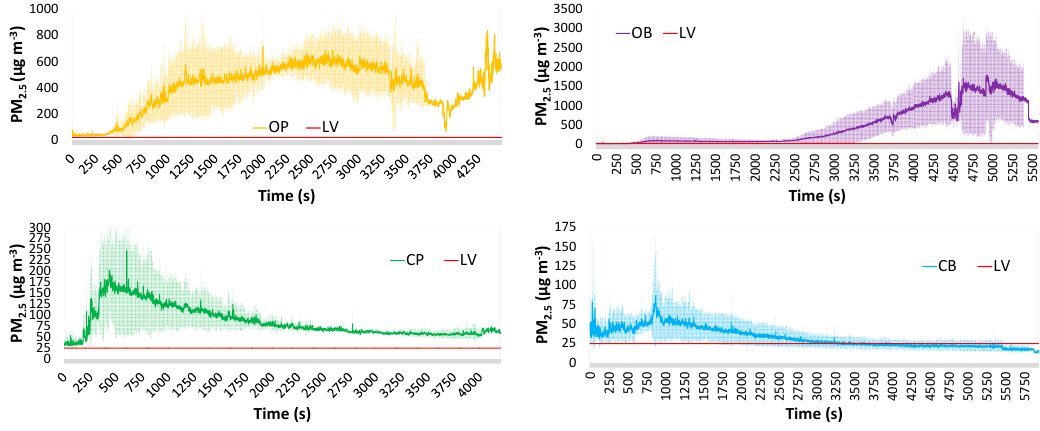
Figure 10. Temporal variability of PM 2.5 (line—mean; light coloured area—standard deviation) during the combustion period for the four studied conditions: ( top , left ) OP—open fireplace and pinewood, ( top , right ) OB—open fireplace and briquettes, ( bottom , left ) CP—closed fireplace and pinewood, and ( bottom , right ) CB—closed fireplace and briquettes. The red line represents the PM 25 limit value of 25 µg·m − 3 defined by the Portuguese legislation [2].